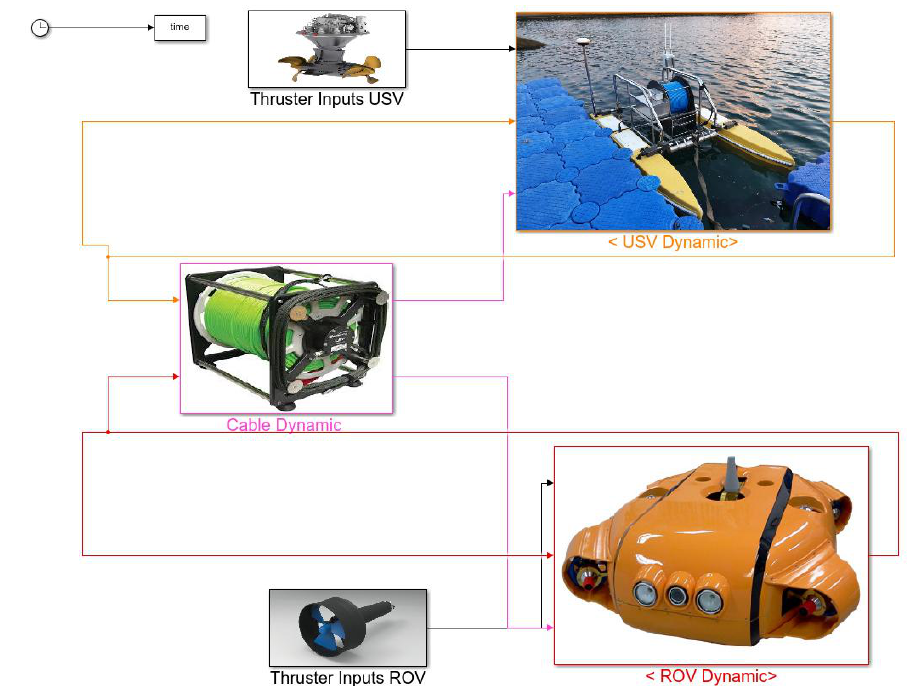
Figure 14. Block diagram of the simulation program.